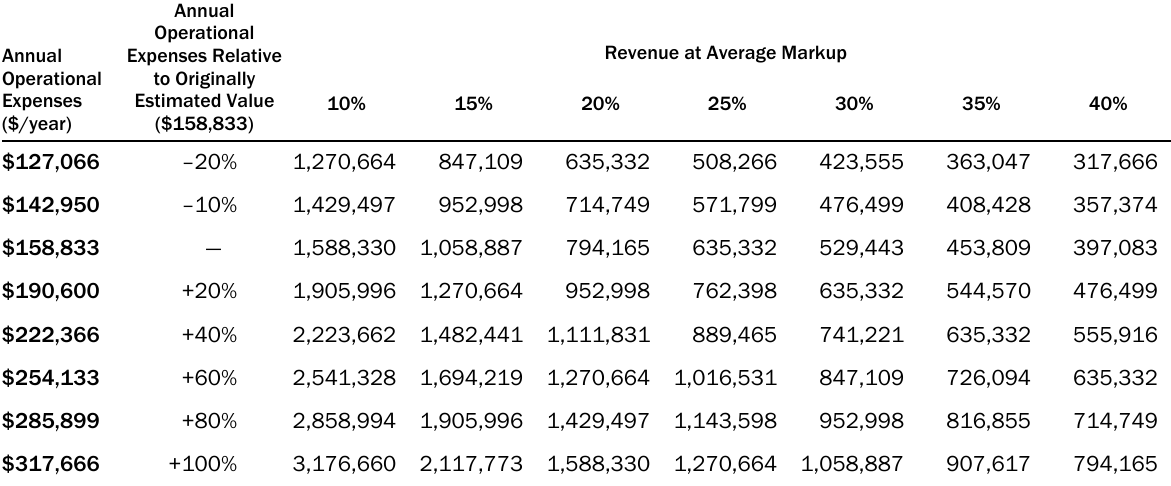
Table 3. Sensitivity Analysis of Minimally Required Revenue from Produce Sales with Respect to Various Levels of Annual Operational Expenses and Average Markup